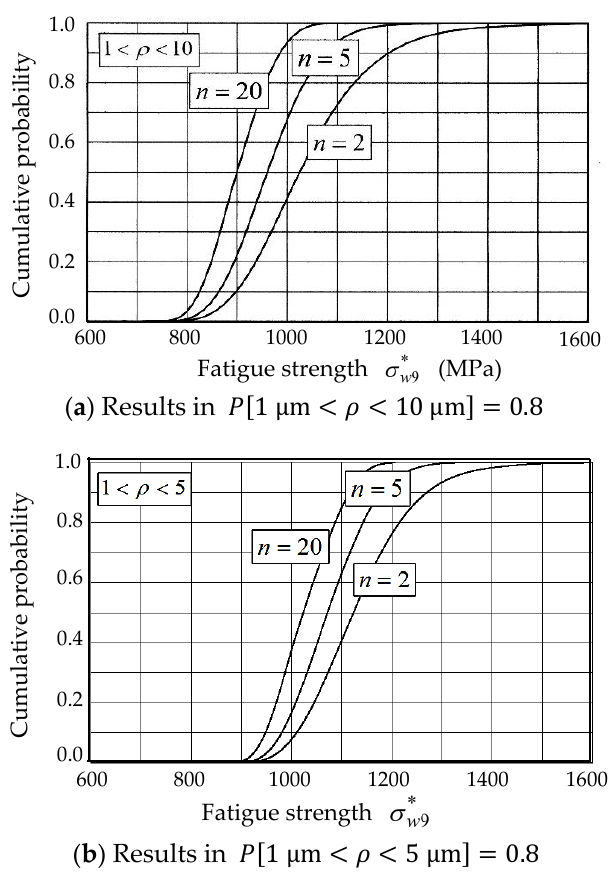
Figure 9. Comparison of cumulative distribution functions in respective conditions.